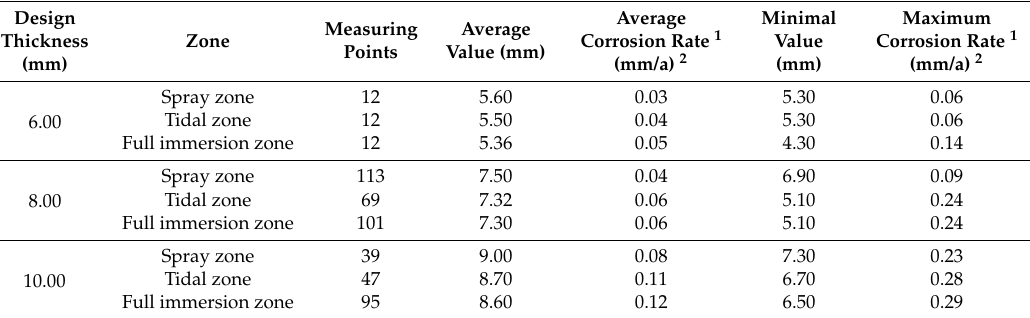
Table 3. Corrosion state classified by design thickness of steel